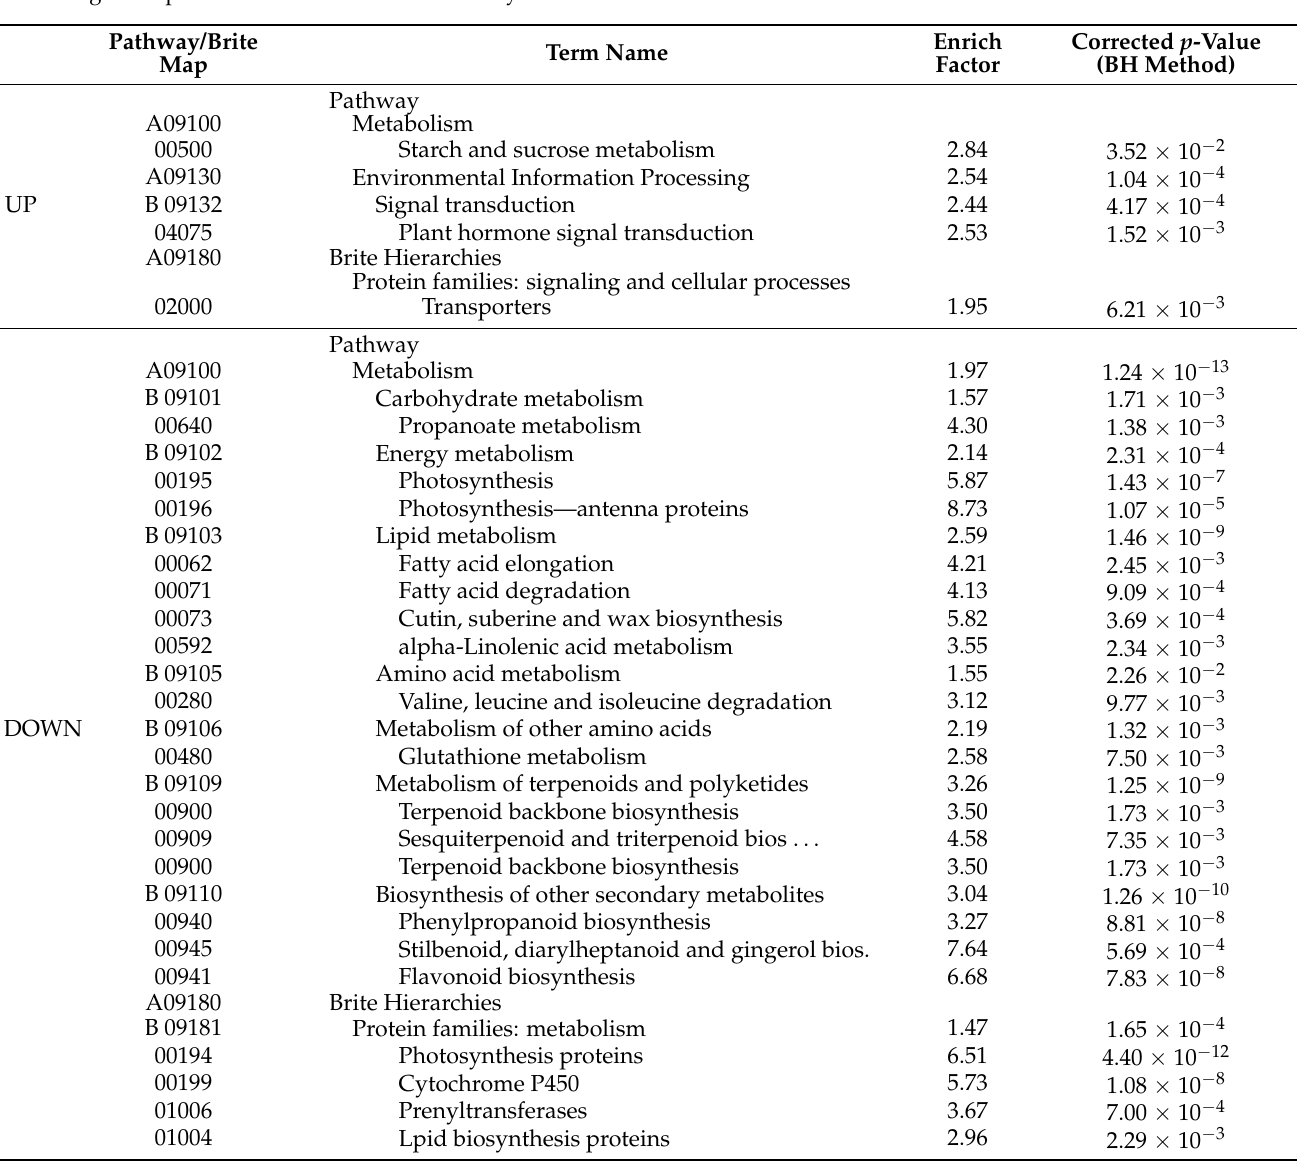
Table 1. Metabolic pathways and BRITE hierarchies were identified as induced (UP) or repressed (DOWN) by KEGG analysis in the albedo of the freshly harvested Navelate fruit in relation to the flavedo samples taken from the same peel samples. Three biological replicates from each condition were used. Only the DEGs ( p ≤ 0.05) showing at least a 2-fold change in expression were included in the